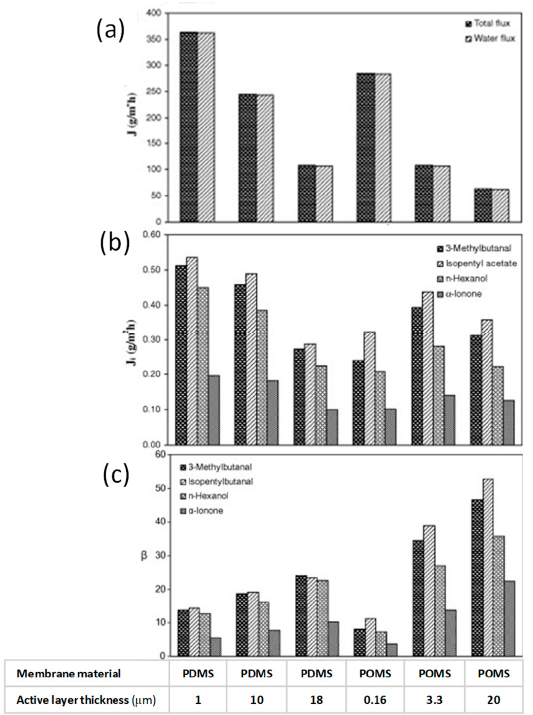
Figure 7. Effect of membrane active layer thickness on total and water flux ( a ), aroma compound fluxes ( b ) and aroma compound enrichment factors ( c ) of PDMS and POMS membranes for pervaporation of pomegranate aroma compounds from their binary feed solutions (adapted from [114]).